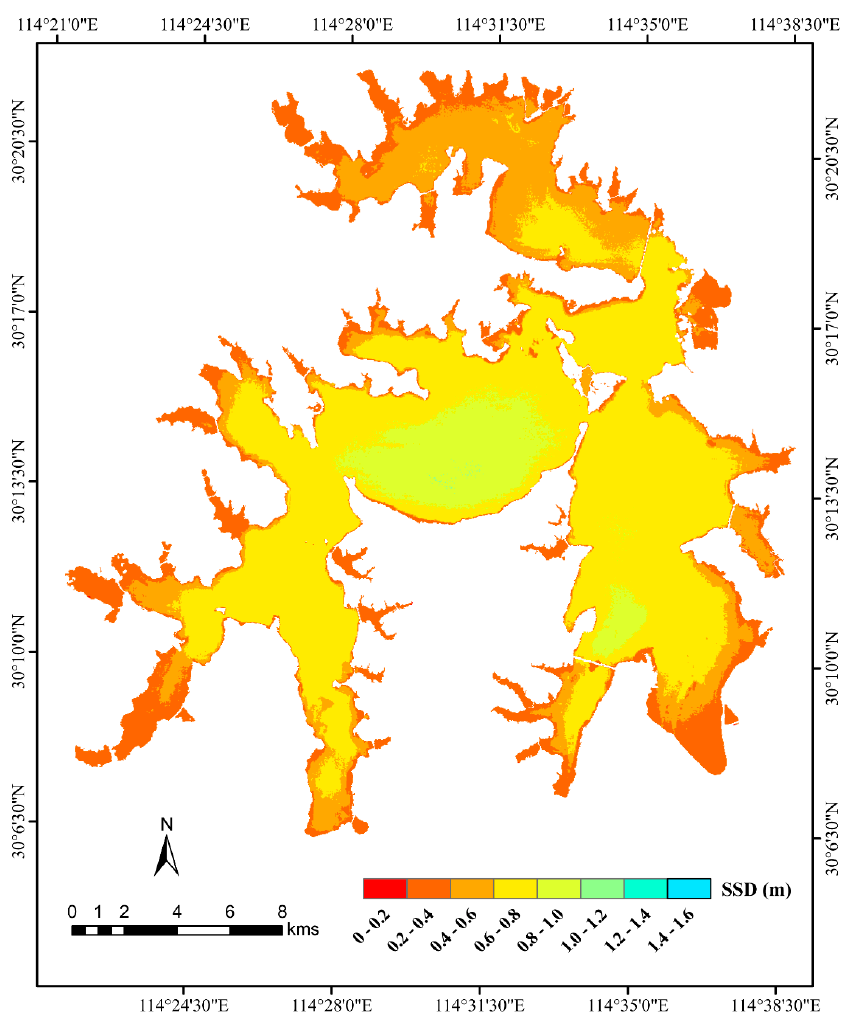
Figure 5. Maps of the averaged SDD retrieved from Landsat images from 2007 to 2016.